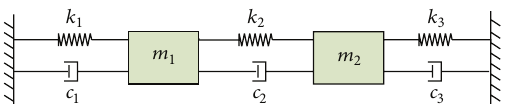
Figure 15: Spring-mass-damper model of closely spaced modes.